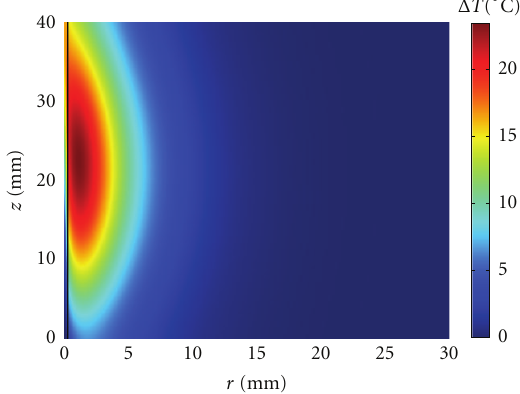
Figure 4: Axial symmetrical temperature increase reached at the end of a 60 s insonation period in a secondary artery ( R = 0 . 3mm, L = 40 mm, V m = 8cm/s). The ultrasound beam is directed downward and the blood flow is moving